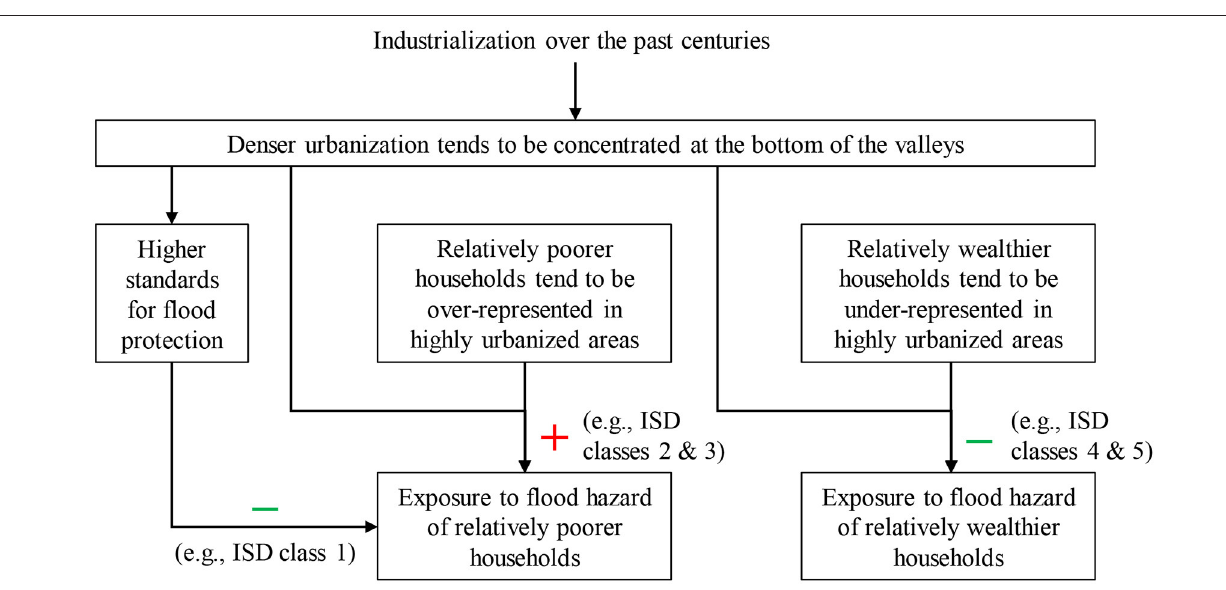
FIGURE 10 | Hypothesis to explain the results obtained at the province